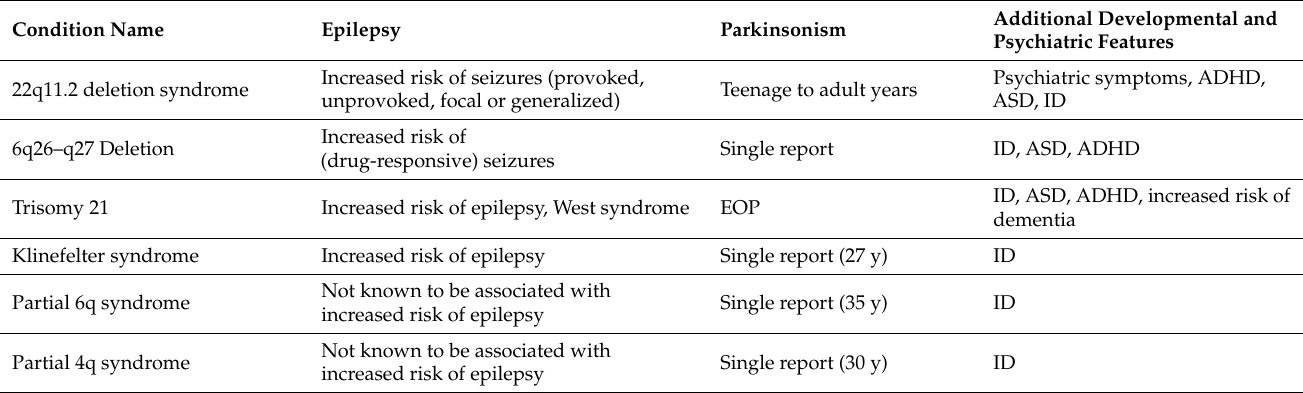
Table 2. Chromosomopathies and copy number variations with increased risk of epilepsy and